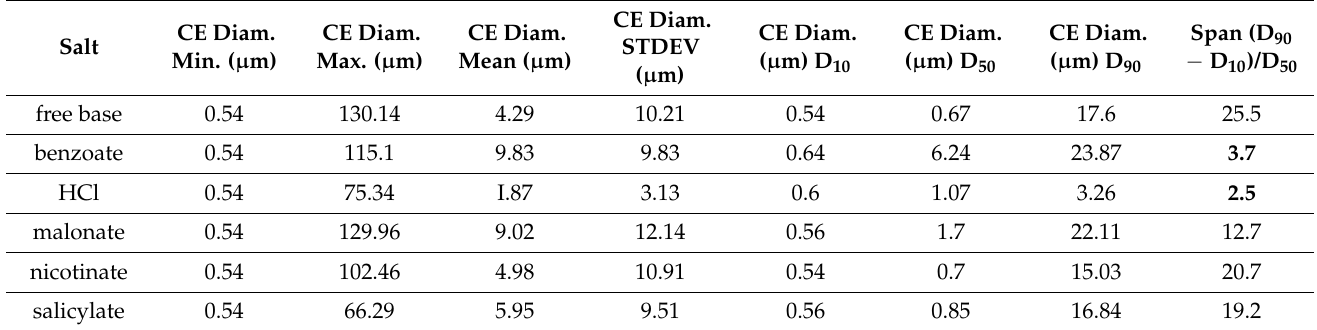
Table 3. Circle equivalent (CE) Diameter (Diam)-number distribution data for bedaquiline salts, using 20 × magnification